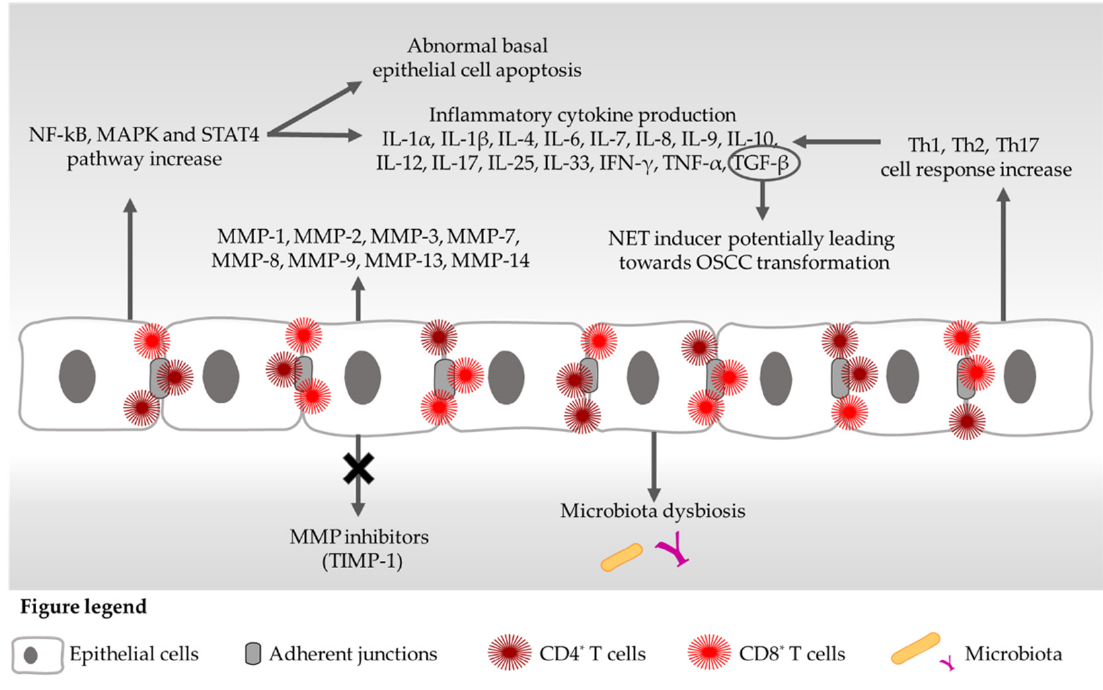
Figure 1. Overview of altered signalling pathways in OLP disease. IFN = interferon; IL = interleukin; MAPK = mitogen-activated protein kinase; MMP = metalloproteinase; NET = neutrophil extracellular trap; NF-kB = nuclear factor-kappa B; OSCC = oral squamous cell carcinoma; STAT = signal transducer and activator of transcription; TIMP = tissue inhibitors of metalloproteinases; TGF = transforming growth factor; Th = T helper cells; TNF = tumour necrosis factor.